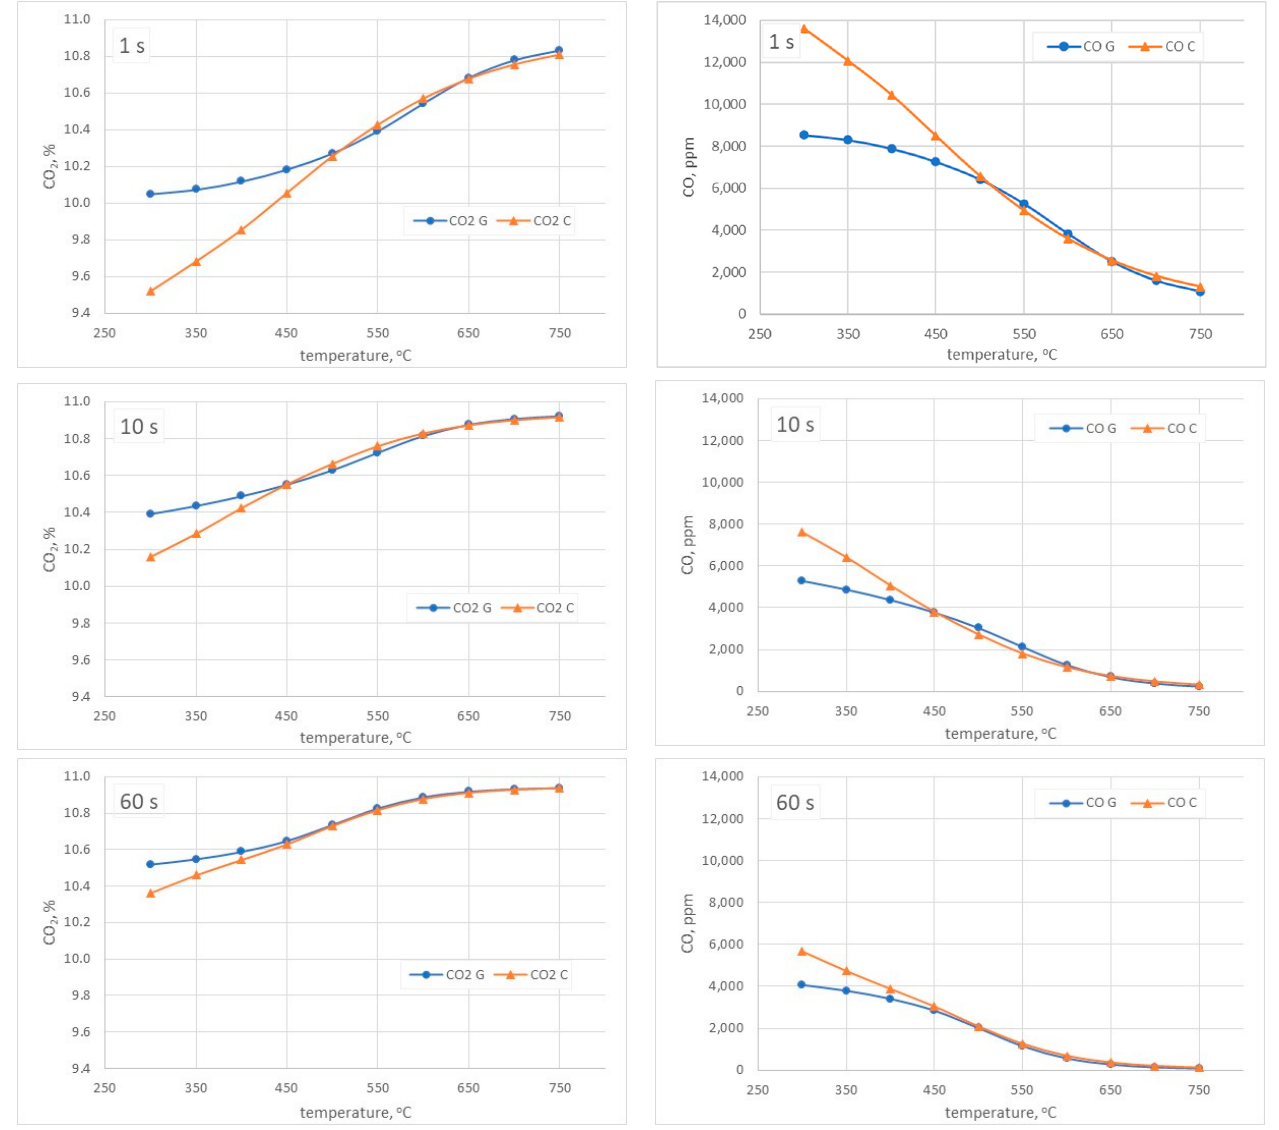
Figure 4. The dependence of CO 2 and CO shares as a function of temperature for the residence time of 1–60